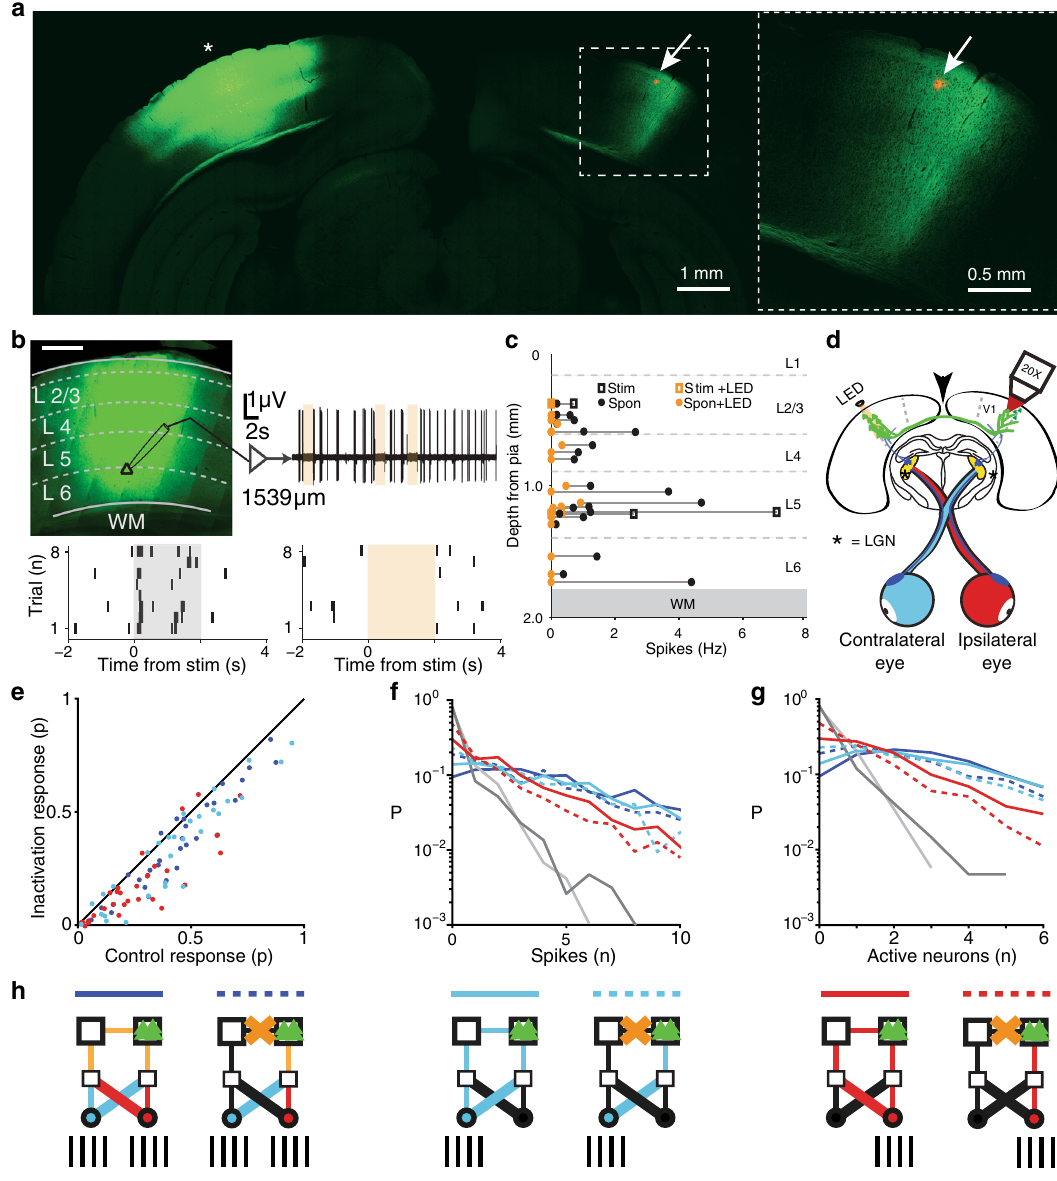
Fig. 3 Anterograde tracing of callosal projection neurons and effects of optogenetic inhibition. a Coronal section of AAV-YFP injection into binocular V1 (asterisk). Right, enlarged view of region outlined by box in left panel. Note the red dye injection site for anatomical identi fi cation (arrow, same as in right). b Coronal V1 section expressing eArchT-YFP (left, scale bar 0.5 mm) and example cell-attached recording from a neuron 1539 µ m below pial surface during periods of spontaneous activity without and with eArchT activation (upper, orange boxes). (Lower) Raster plots from a cell-attached recording showing responses to visual stimuli without (left) and with eArchT activation (right, orange box). c Pooled data of fi ring rates before (black) and during activation of eArchT (orange) with recording depth for both spontaneous activity (circles) and stimulus-evoked activity (squares). d Schematic showing ipsilateral population imaging site (objective lens), location of contralateral callosal projecting neurons (arrow), ipsilateral (red) and contralateral (turquoise) eye crossed optical pathway targeting lateral geniculate nuclei (LGN, star). Uncrossed pathways in blue. e Average response probabilities from populations of visually responsive neurons (6 populations with 41 neurons) during binocular (blue), contralateral (turquoise), and ipsilateral stimulation (red) to moving gratings across all eight angles with and without inactivation of vc pathway. f Probability distributions of number of inferred action potentials evoked per stimulus period in a set population of visually responsive neurons ( fi ve populations with six neurons each) during binocular (blue), contralateral (turquoise), ipsilateral (red) stimulation, spontaneous (dark gray), and shuf fl ed (Poisson) spontaneous (light gray). Dashed lines indicate inactivation of vc pathway. g Probability distributions of number of active neurons per stimulus period. Populations and line conventions as in f . h Diagrams depicting visual pathways activated during different conditions in f , g ; unbroken lines control, dashed lines vc pathway inactivation. Direct (turquoise, red, vertical) and crossed (turquoise, red, diagonal) visual pathways, LGN (small square), contralateral (large open square) and ipsilateral (large square, green triangles) cortex, with callosal pathway (line between large squares) intact or inactivated (yellow cross). Left panel: Binocular stimulation (lower bars). Middle panel: Contralateral stimulation. Right panel: Ipsilateral